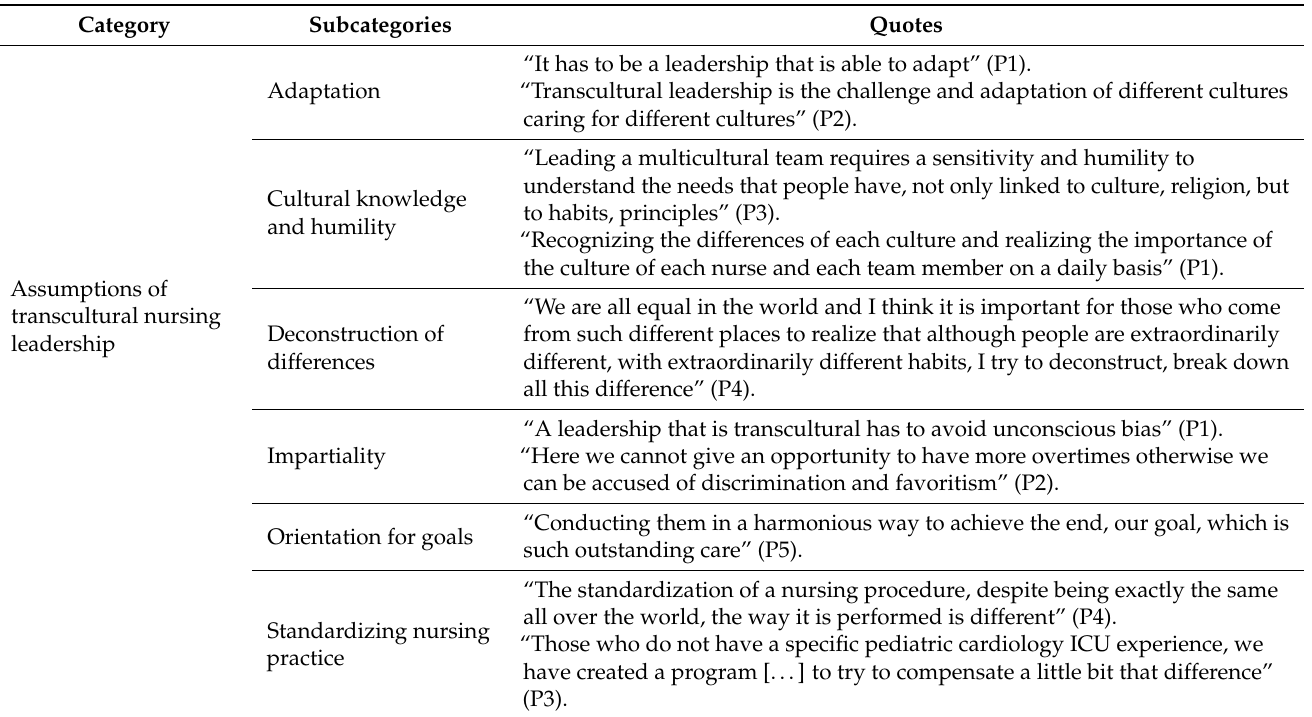
Table 1. Subcategories of the “Assumptions of transcultural nursing leadership” category and participants’ quotes. Category